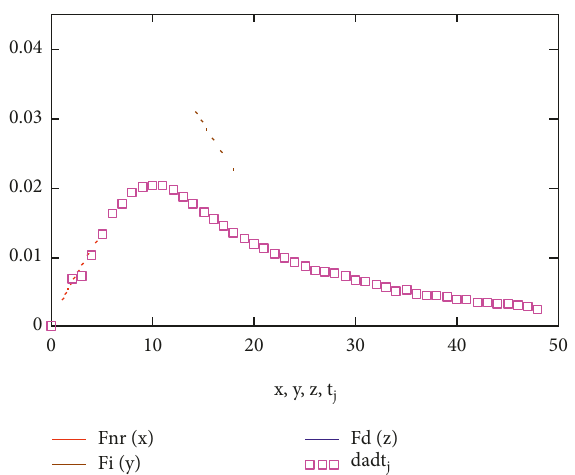
Figure 7: Hydration rate curves of sample C30SZ.